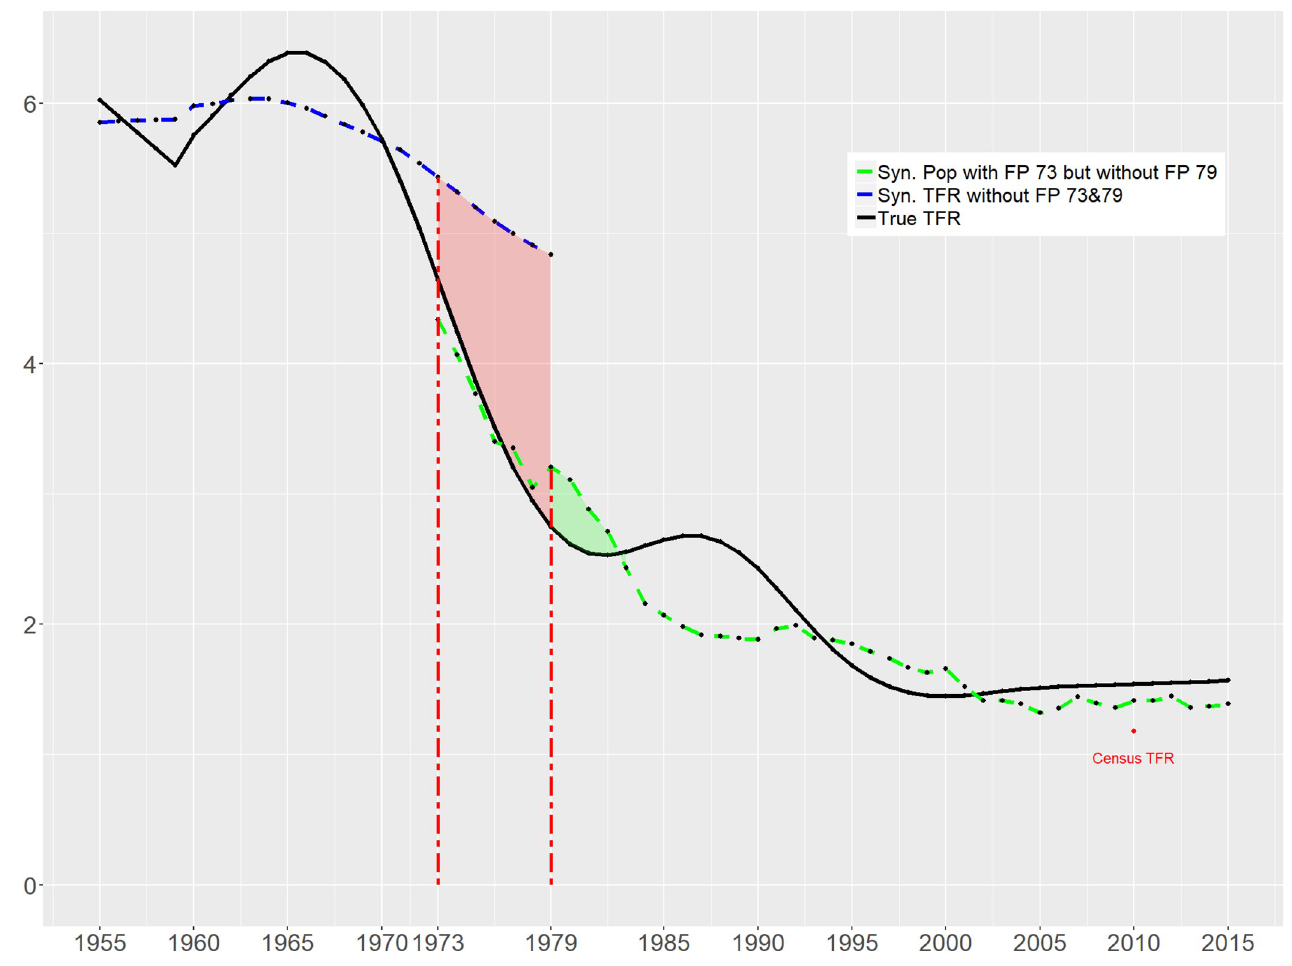
Fig 1. Time trend of ‘actual’ and ‘synthetic’ Total Fertility Rate for China, 1955–2015.